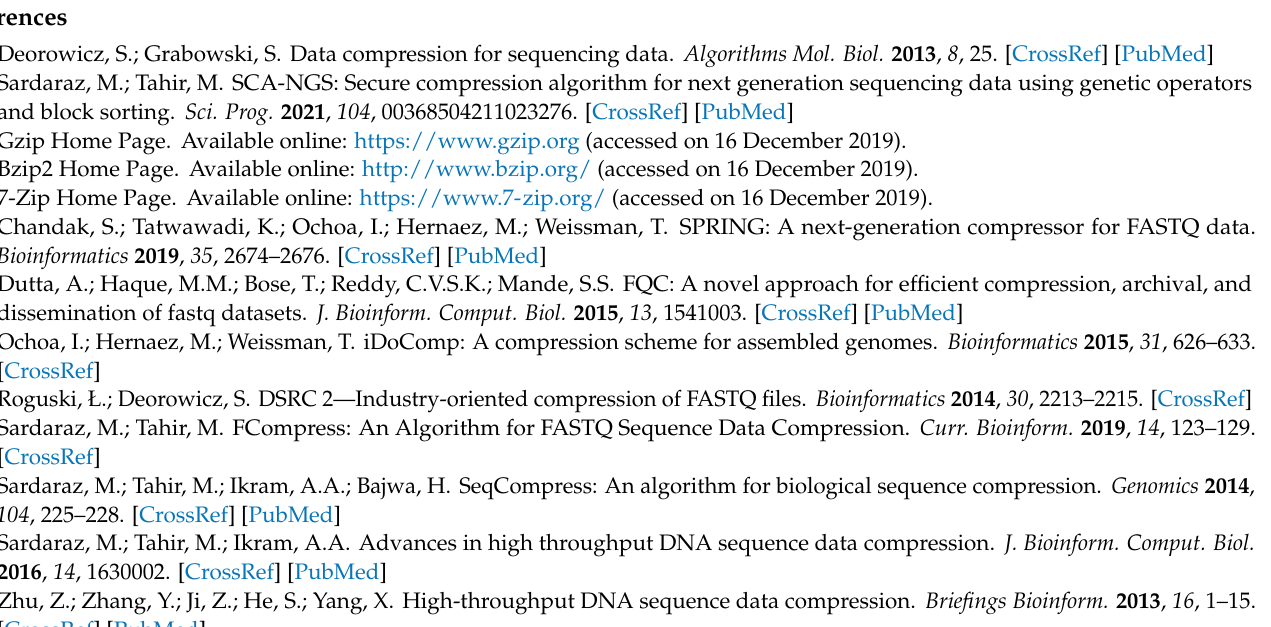
and compression ratio